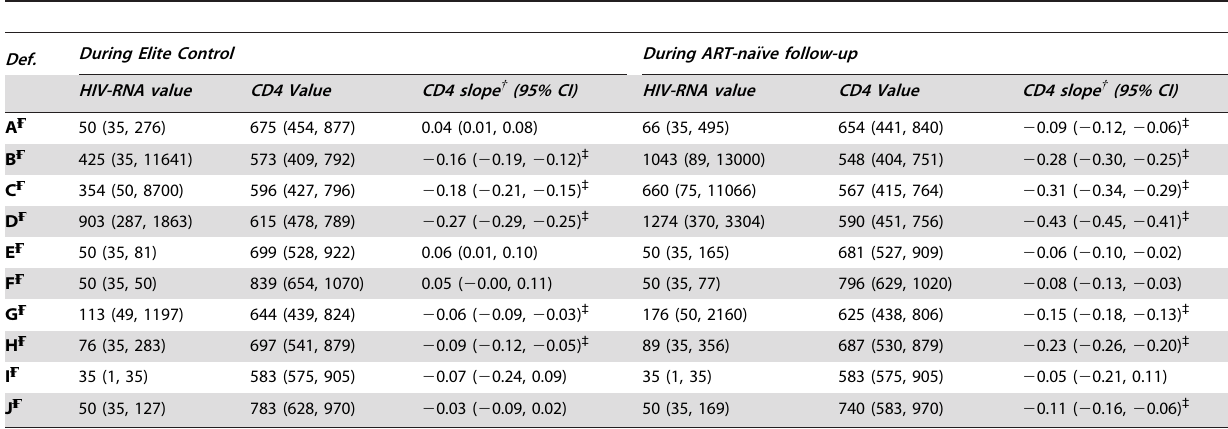
Table 5. HIV-RNA and CD4 values and estimated CD4 slope during elite control (EC), and throughout ART-naı¨ve follow-up using the CASCADE dataset applied to 10 definitions of EC found in the literature.